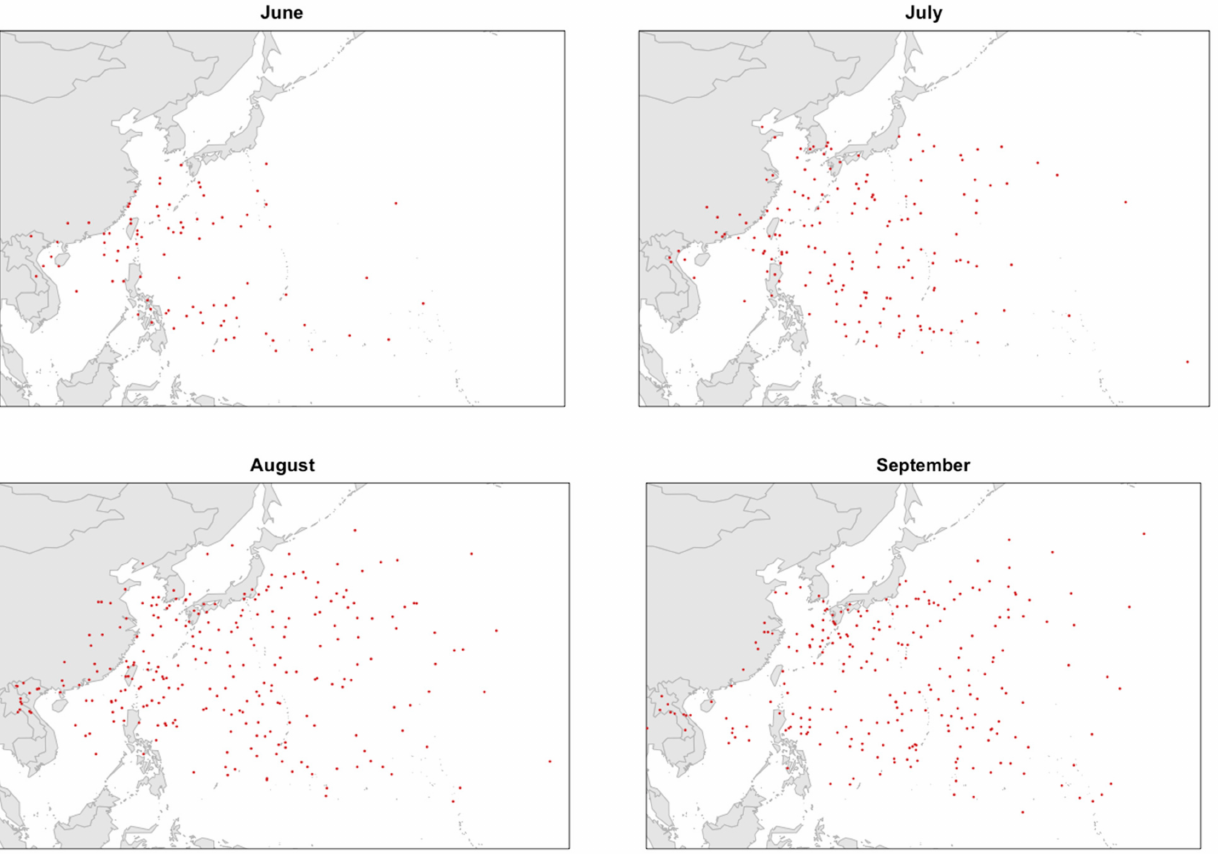
Figure 2. Distribution of WNP region observed genesis points in June–September. Red dots indicate genesis